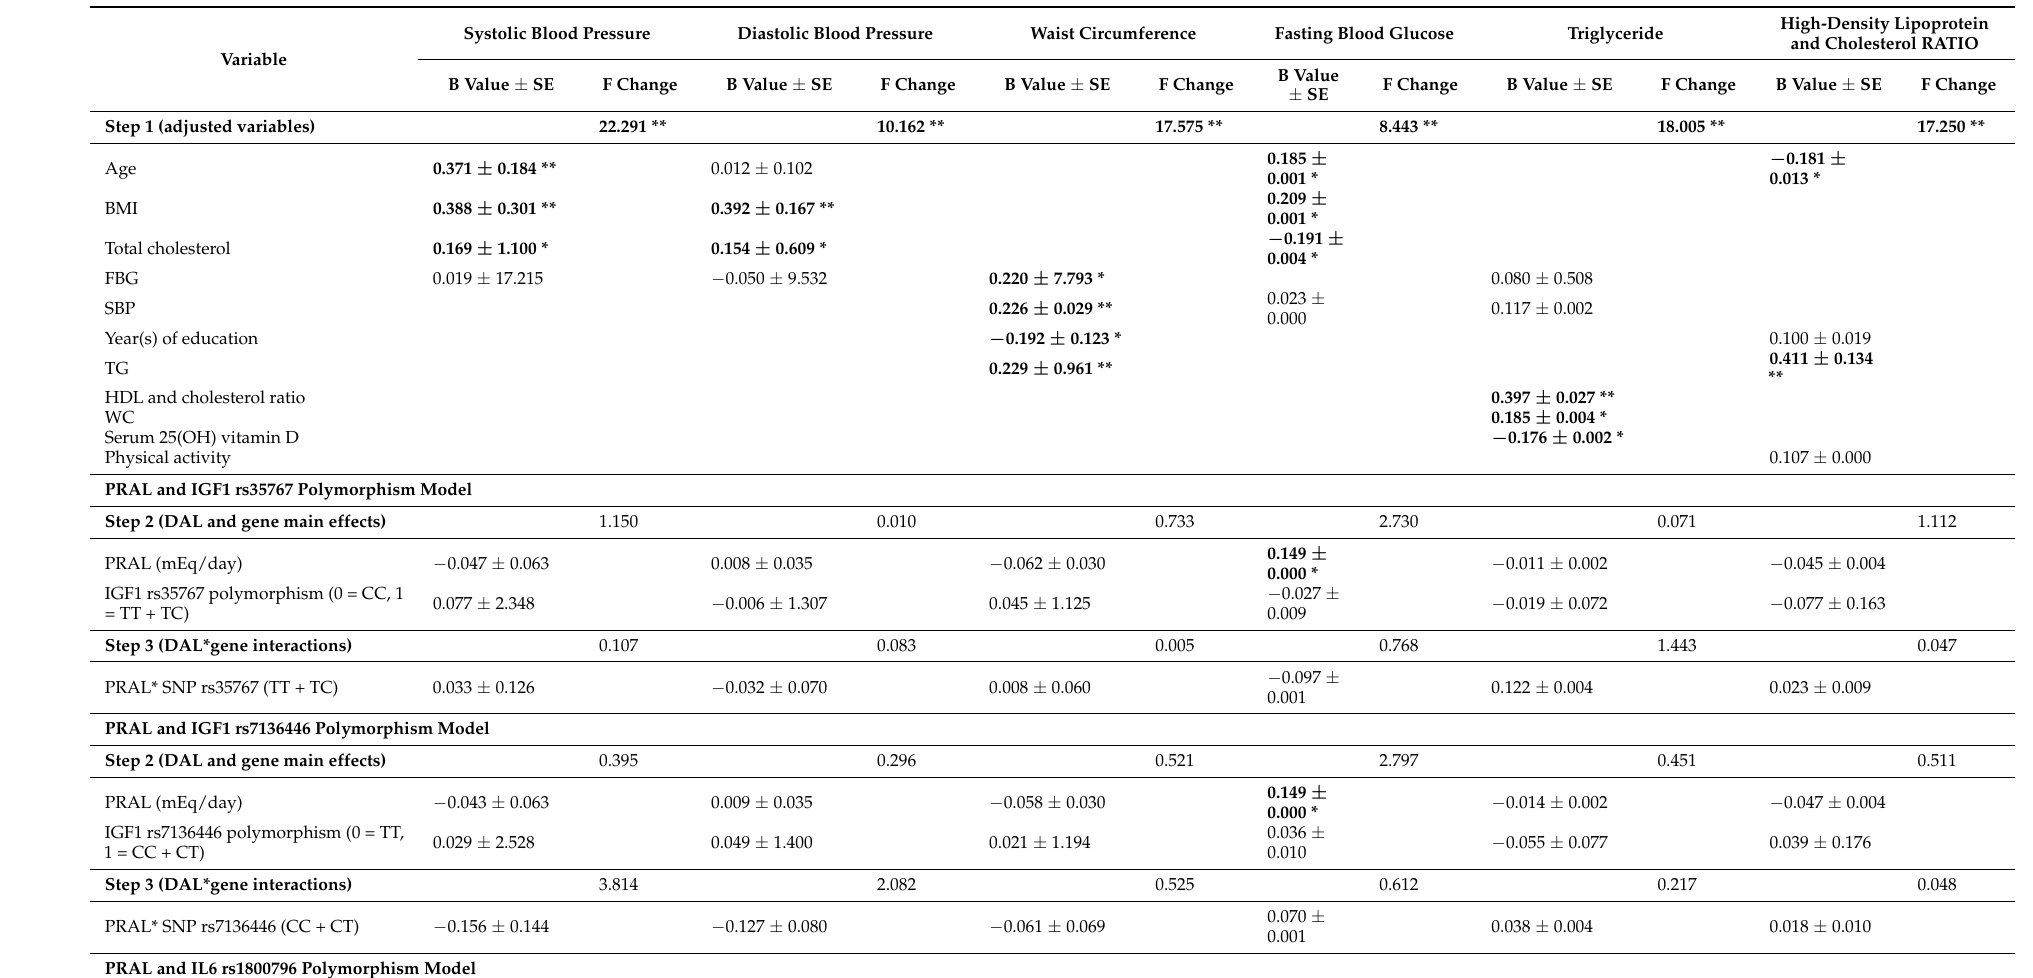
Table 4. Hierarchical linear regression analyses on gene − DAL interaction effects on metabolic